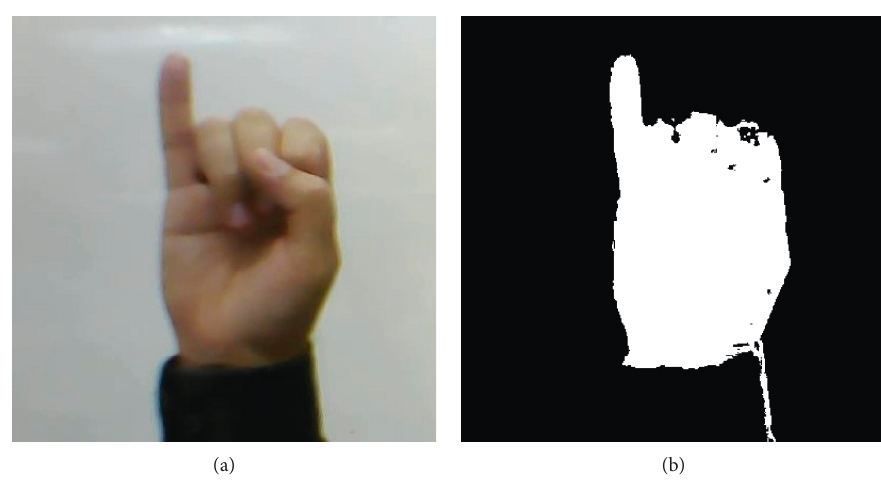
Figure 7: Original image (a) and faulty segmentation (b).